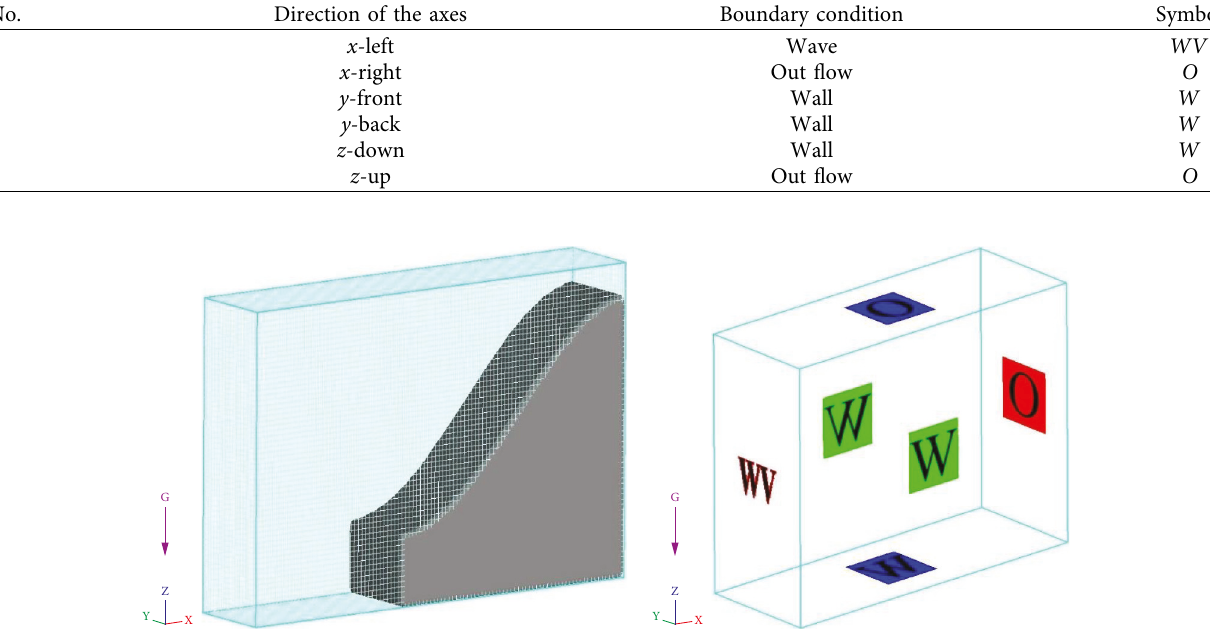
0.015) in this research. ×